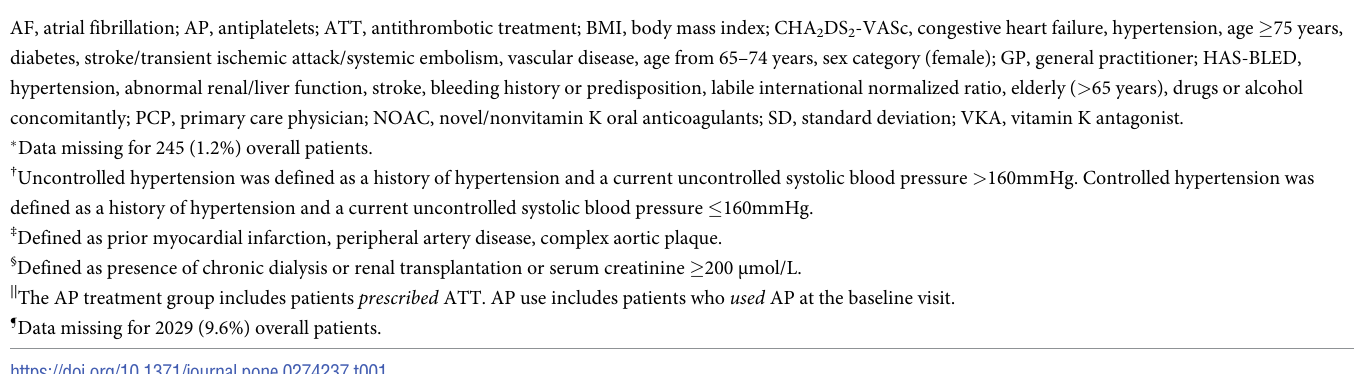
Table 2. Multivariable logistic regression model (Model 2) � estimates of fitted probabilities of ATT prescription. ATT strategy Marginal fitted probability